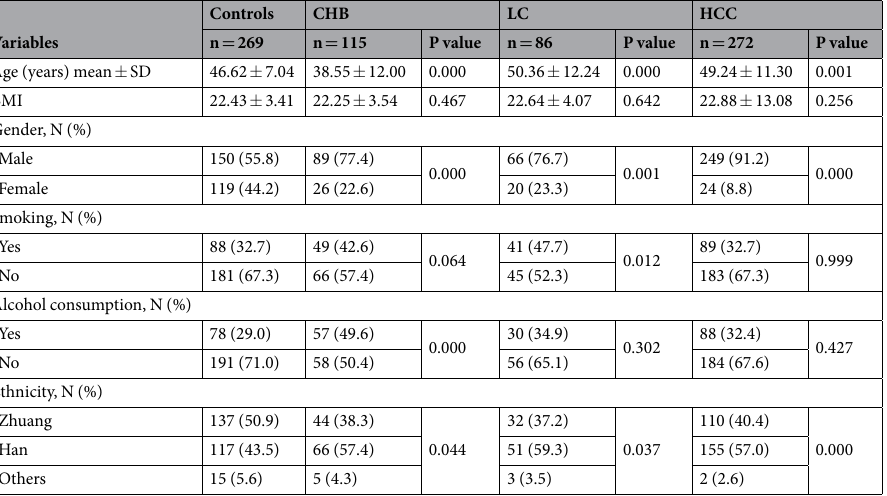
Table 1. Demographic and clinical characteristics of the study subjects. CHB = chronic hepatitis B, LC = liver cirrhosis, HCC = hepatocellular carcinoma, BMI = body mass index, SD = standard